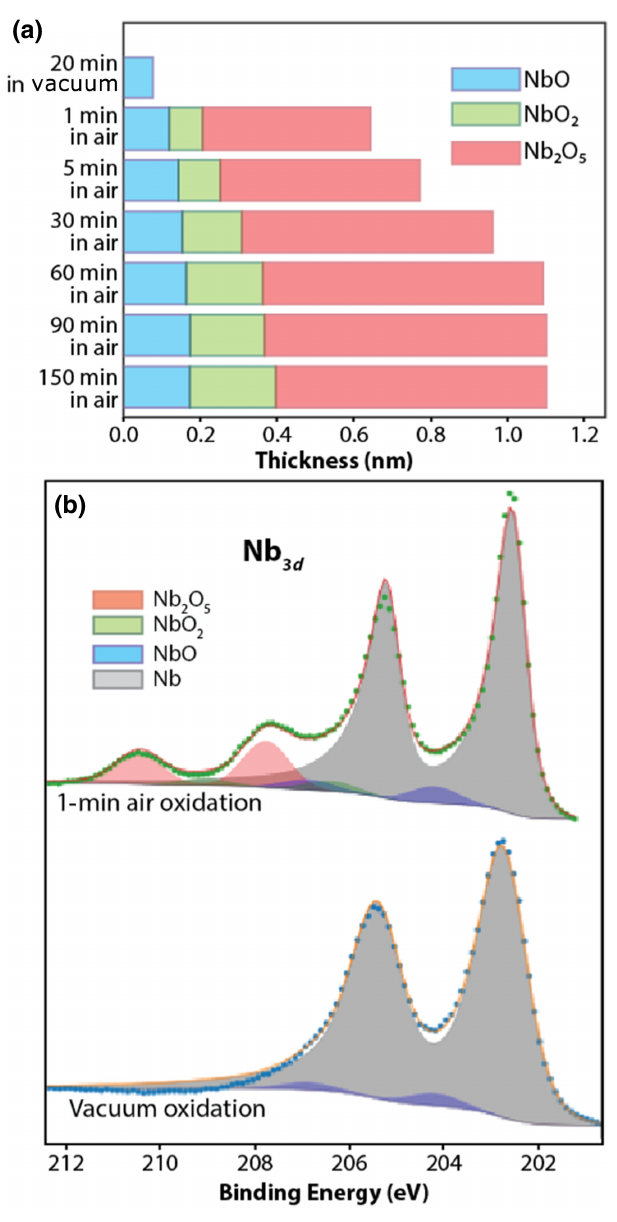
FIG. 12. Reoxidation of sputter-cleaned Nb in high vacuum and air. (a) The growth of Nb 2 O 5 and suboxides with air expo- sure. After 60 min, approximately 1.1 nm of niobium oxide has formed and the oxidation rate has decreased significantly.